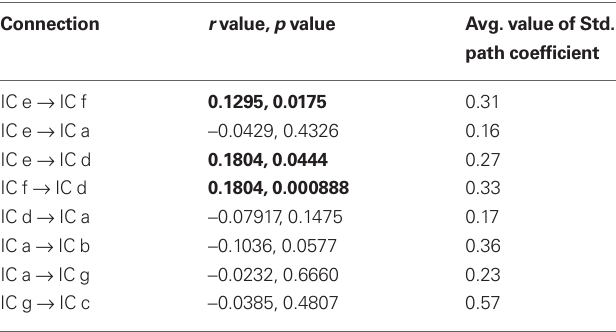
Table 3 | The age-related changes in the standardized path coefficients (r and p value) for the SeM shown in Figure 5 are shown in column 2 as Pearson correlations between the path coefficient and age. Column 3 shows the average value of each standardized path coefficient for the entire age range of 5–18 years included in the analysis. Path coeffiences with a significant age correlations are highlighted in bold font